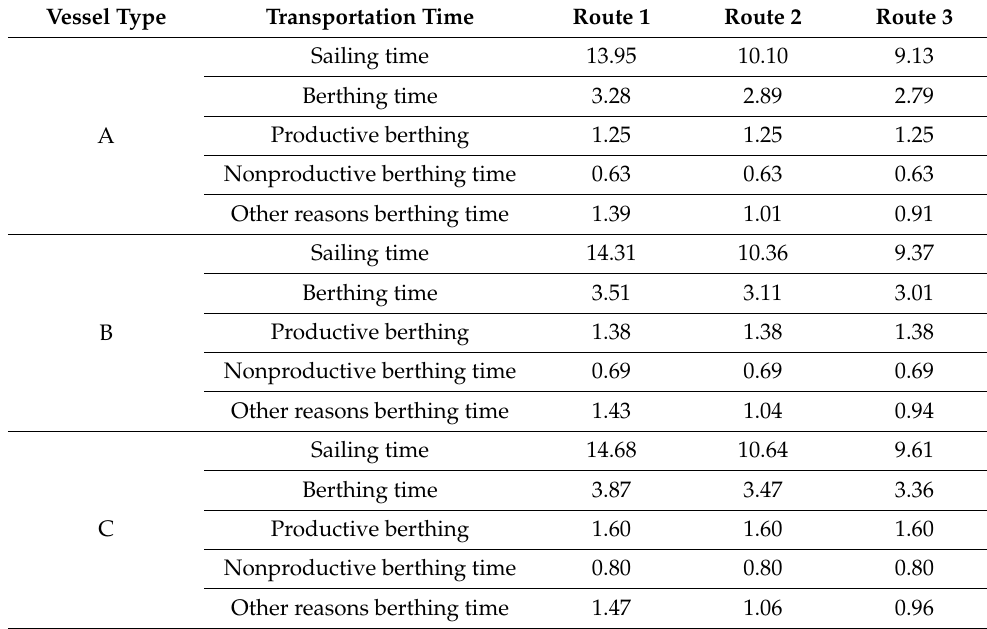
Table 4. Calculation of the voyage time (unit: